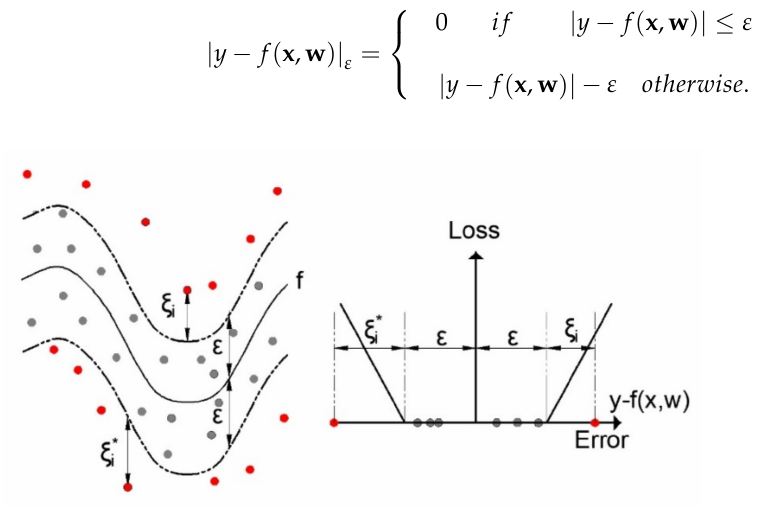
Figure 5. Nonlinear SVR with ε -insensitivity